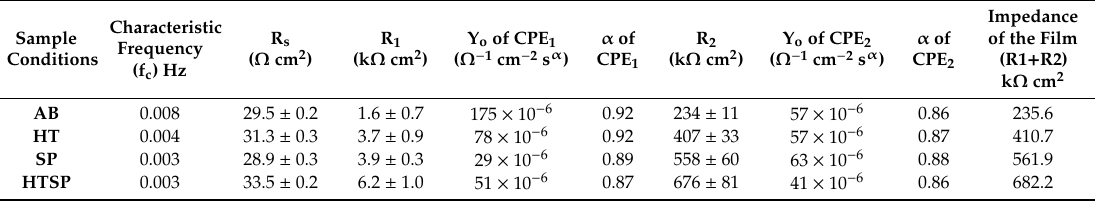
Table 4. Fitted parameters obtained from EIS